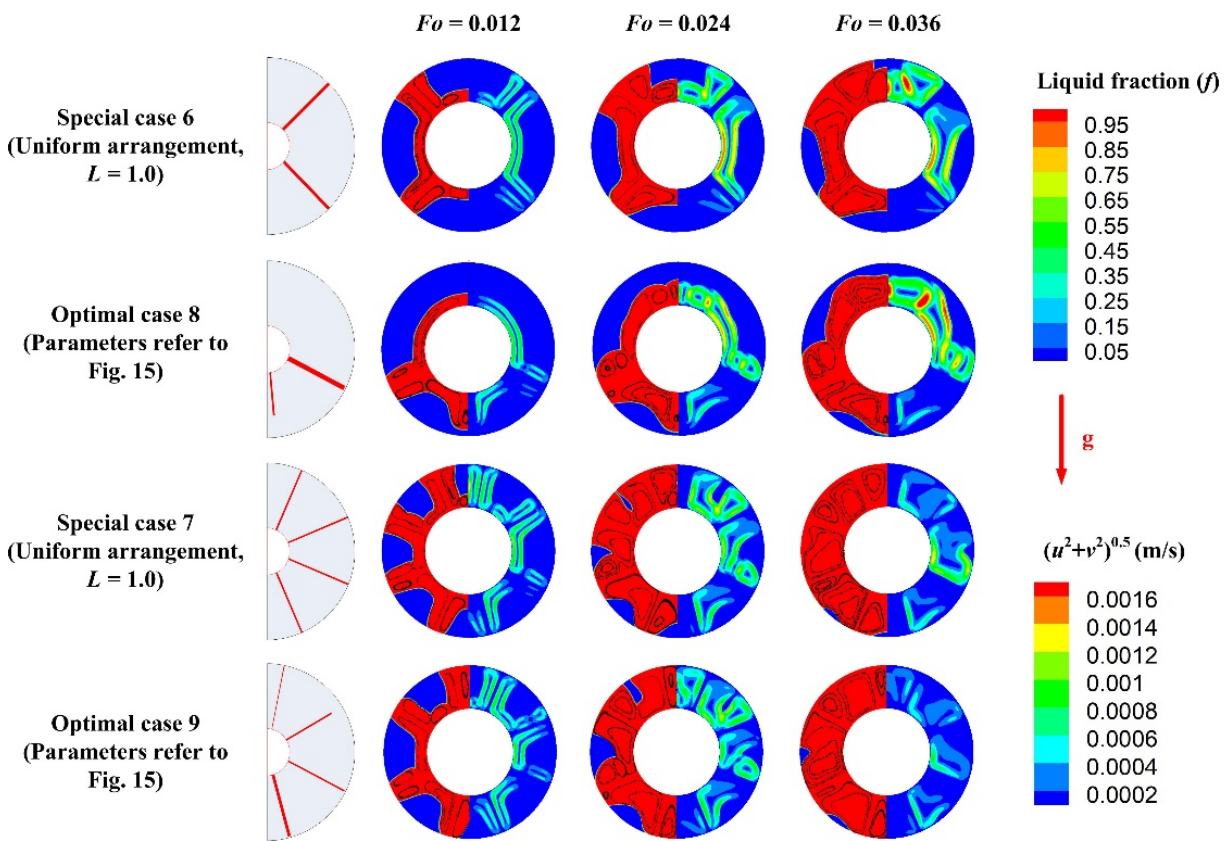
Figure 16. Contour maps of liquid fraction and velocity magnitude for Special Cases 6 and 7 and Optimal Cases 8 and 9.